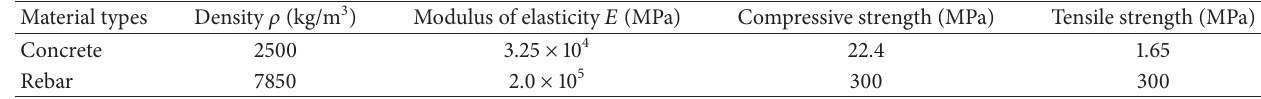
Table 1: Material parameters of concrete piers.